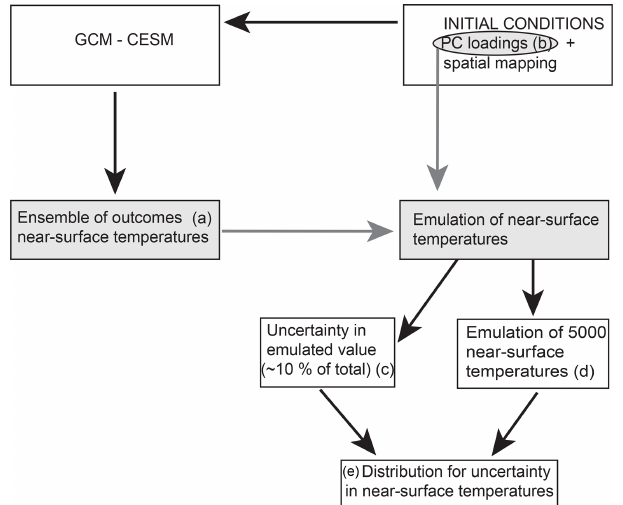
Figure 1. Schematic describing the sequence of events undertaken in this study. The gray boxes and circle indicate the elements related to the emulator creation. The letters in parentheses are used in the text for